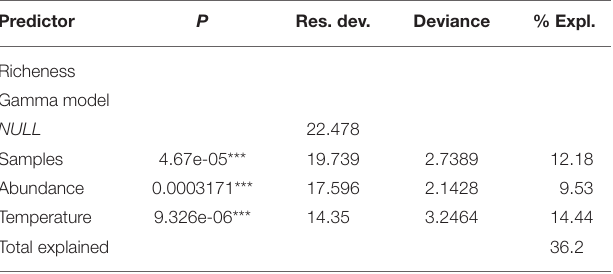
TABLE 4 | Variability and adjustment for the logistic and gamma general linear models fitted to the fish richness values of the Tramandaí River estuary (TRE) and marine adjacent coastal area (AC). Res. dev.